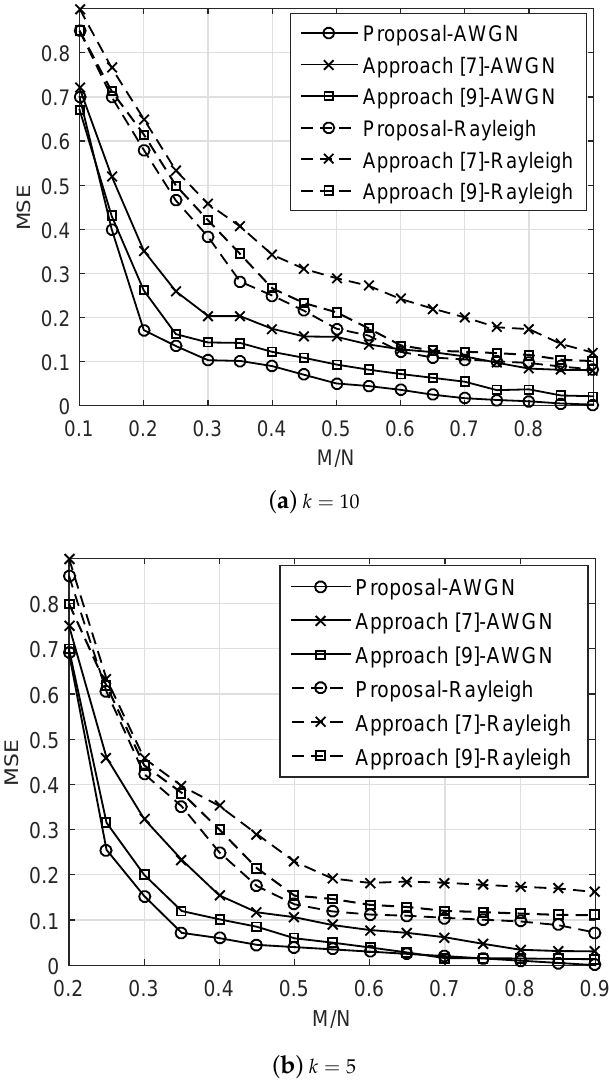
Figure 1. MSE versus different compressed ratios with fading